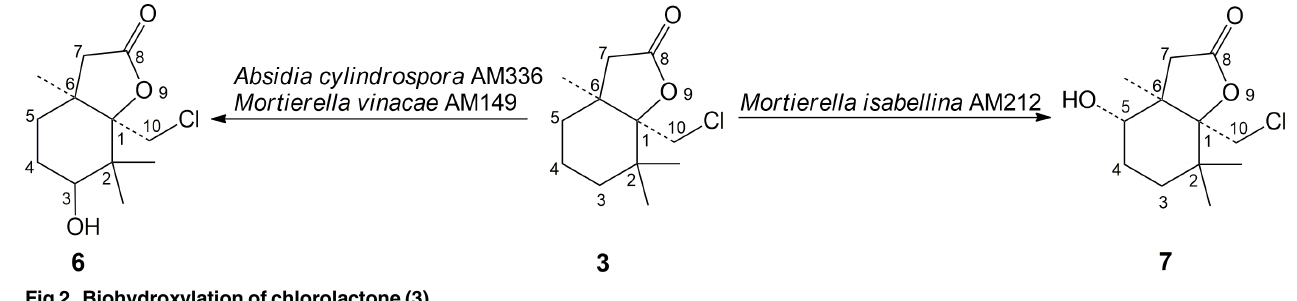
Fig 2. Biohydroxylation of chlorolactone